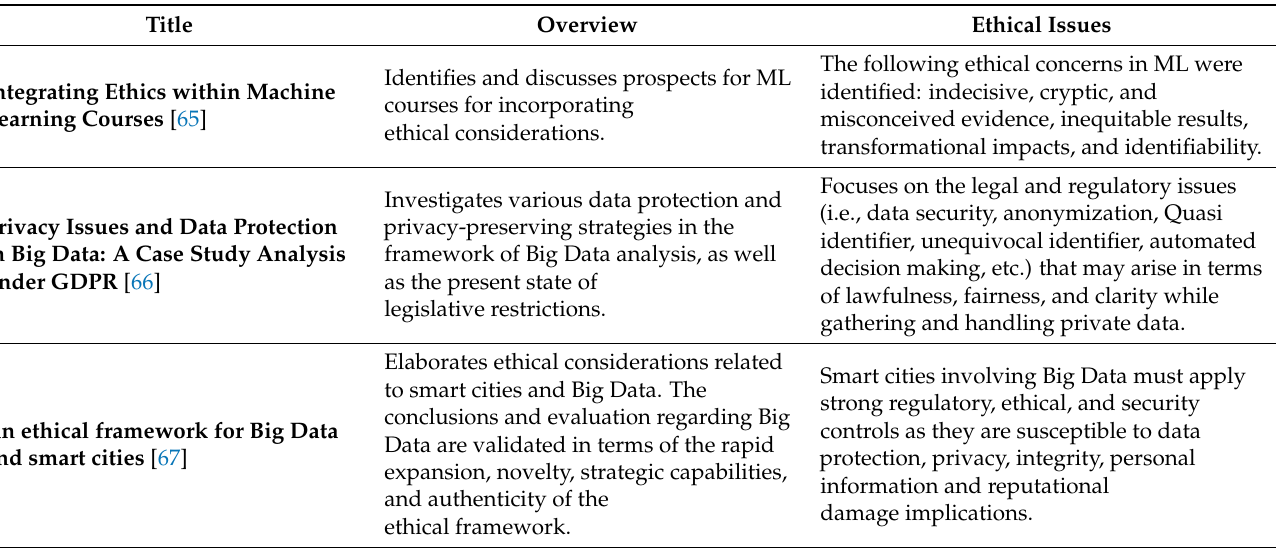
Table 5. Ethical and Privacy issues in Big Data and ML.